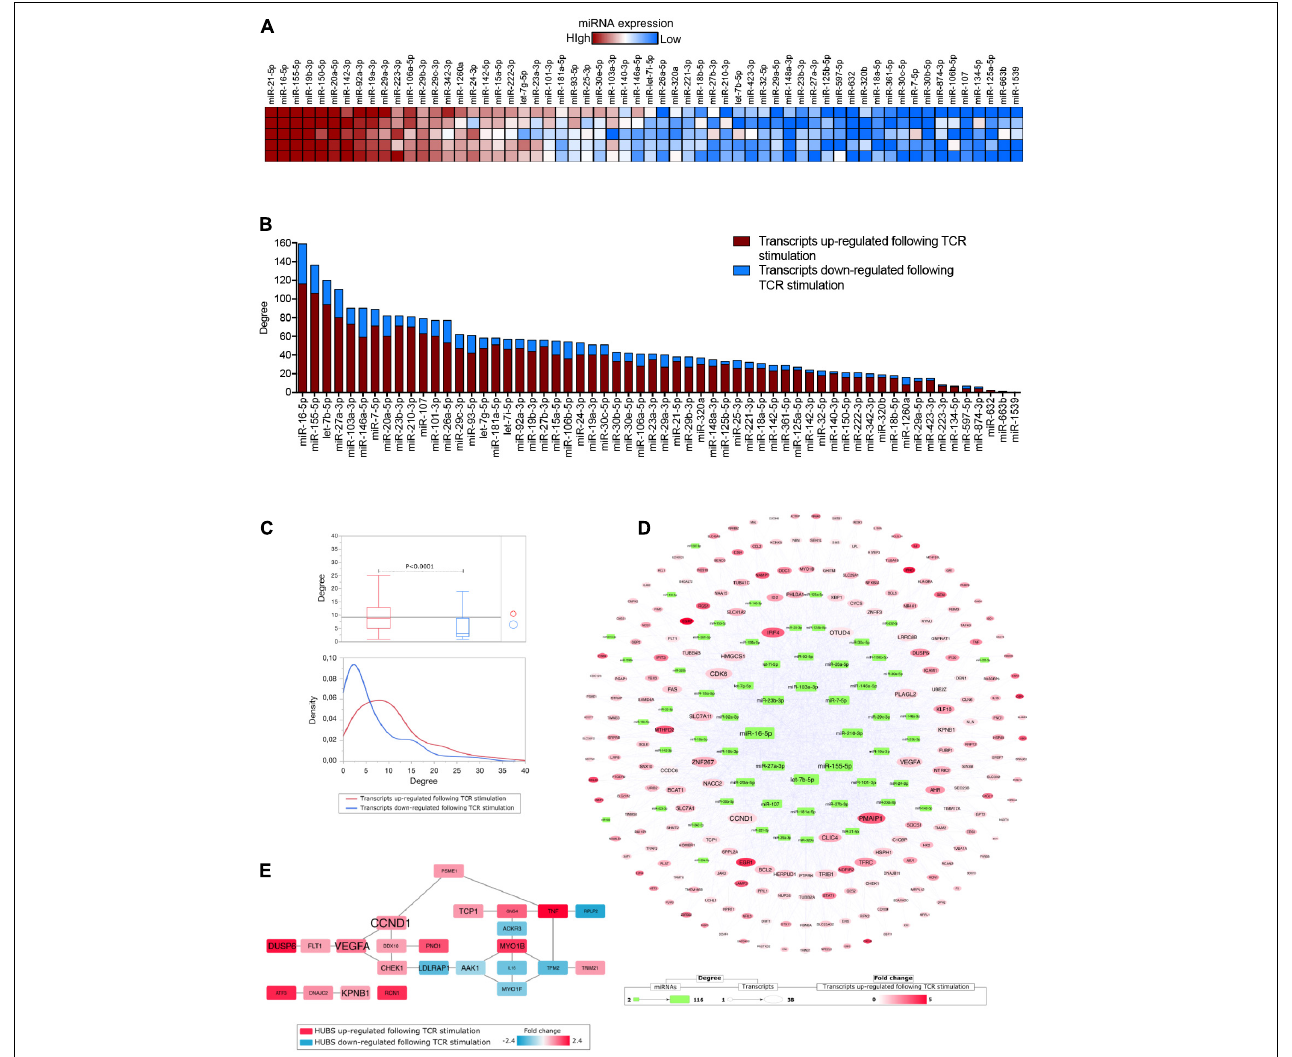
FIGURE 1 | (A) Heatmap showing miRNA expression ( n = 60) in extracellular vesicles released by in vitro TCR-stimulated Tconv cells (isolated from five healthy donors). Each molecule was normalized by miRNA global mean and ranked based on relative mean expression value from the most to the least expressed. (B) Bar histogram showing the number of miRNA targets (among those transcripts either upregulated, red, or downregulated, blue, following TCR stimulation) for each of the 60 detectable Tconv-derived EV-miRNAs, ranked based on target total number. (C) Box plots comparing the number of miRNA–target interactions (degree, upper panel) and density distribution of the interactions (lower panel) distinguishing the transcripts (targets) for being either upregulated (red) or downregulated (blue) following TCR stimulation (Student’s t -test, p < 0.0001). (D) MiRNAs–targets network reconstructed considering only transcripts upregulated following TCR stimulation. (E) Protein–protein interaction HUBS selected by considering Betweenness, Bridging, and Centroid centralities; the gene name size is proportional to the number of miRNAs targeting